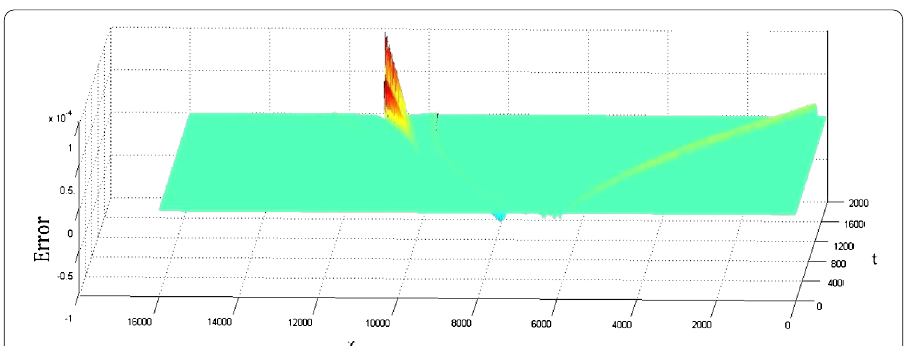
Figure 2 The absolute error photo of the CNFD solution for 0 ≤ x ≤ 16,000 and 0 ≤ t ≤